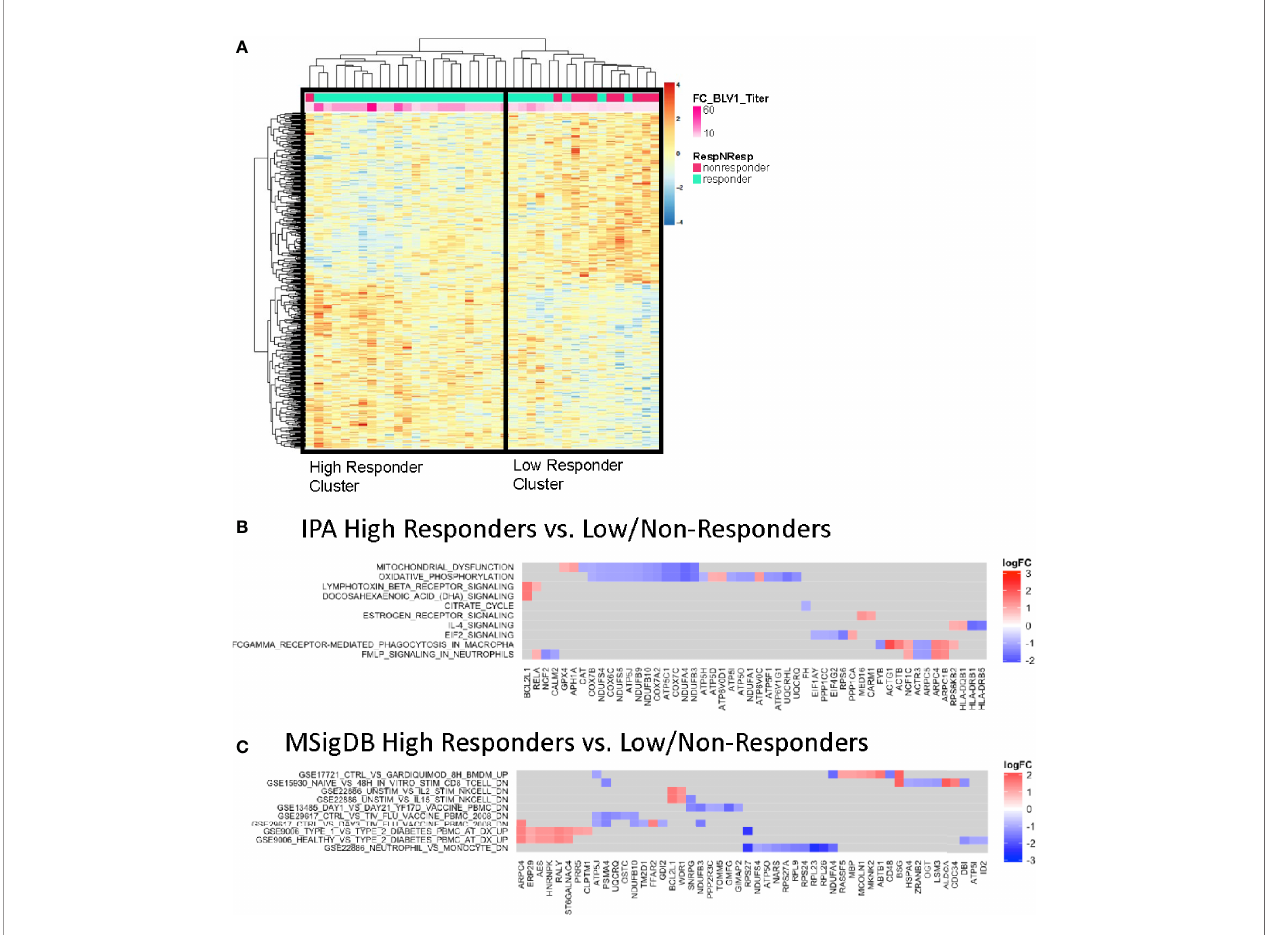
FIGURE 2 | Baseline Enriched Molecular Pathways Associated with Antibody Titer Response. (A) Heatmap representation of the top 1,000 signi fi cantly correlated transcripts by regressing baseline gene expression from all participants against V1 pH1N1 titer. The expression intensities are represented using a blue-white-red color scale. Rows correspond to probes and columns correspond to pro fi led samples (p ≤ 0.01). High responder and Low/non responder clusters were compared and subjected to gene set enrichment analysis using the IPA database (B) and MSigDB immunologic signature model (C)